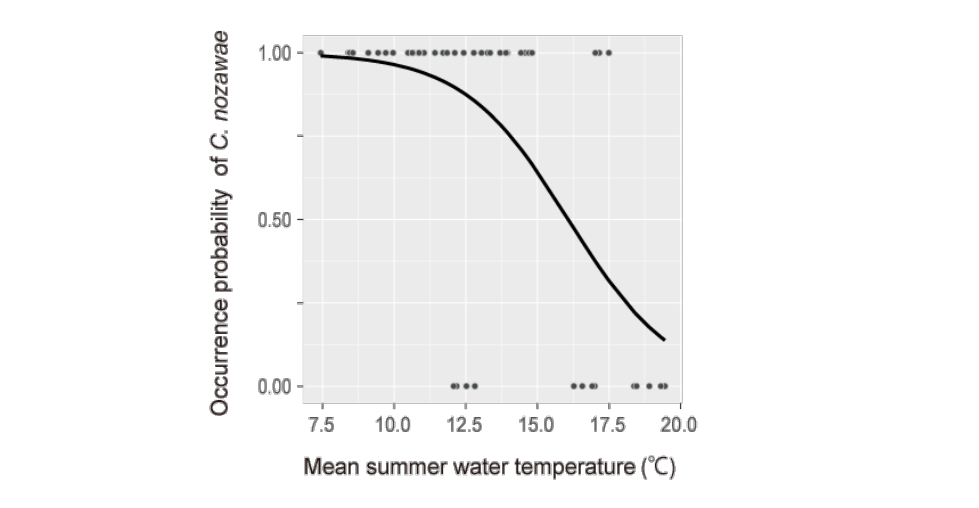
nozawae occurrence. The black circles and line indicate the observed data and the predicted proba-